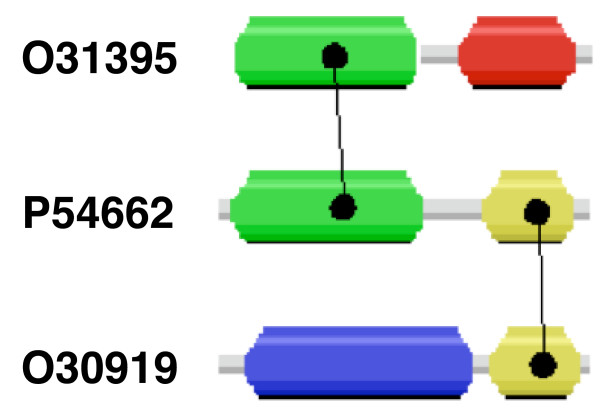
Multi domain proteins and the trap of false transitivity. Three bacterial proteins are shown. Boxes represent domains, colored by their Pfam classification. Red = C terminal transcriptional regulatory domain; Green = Response regulator receiver domain; Yellow = luxR family, Blue = Autoinducer binding domain; Thin lines mark similarity of domains. The protein [Swiss-Prot:P54662] is similar to each of the two other proteins via a different domain, therefore careless use of transitivity might lead to the false conclusion that [Swiss-Prot:O31395] is similar to [Swiss-Prot:O30919].